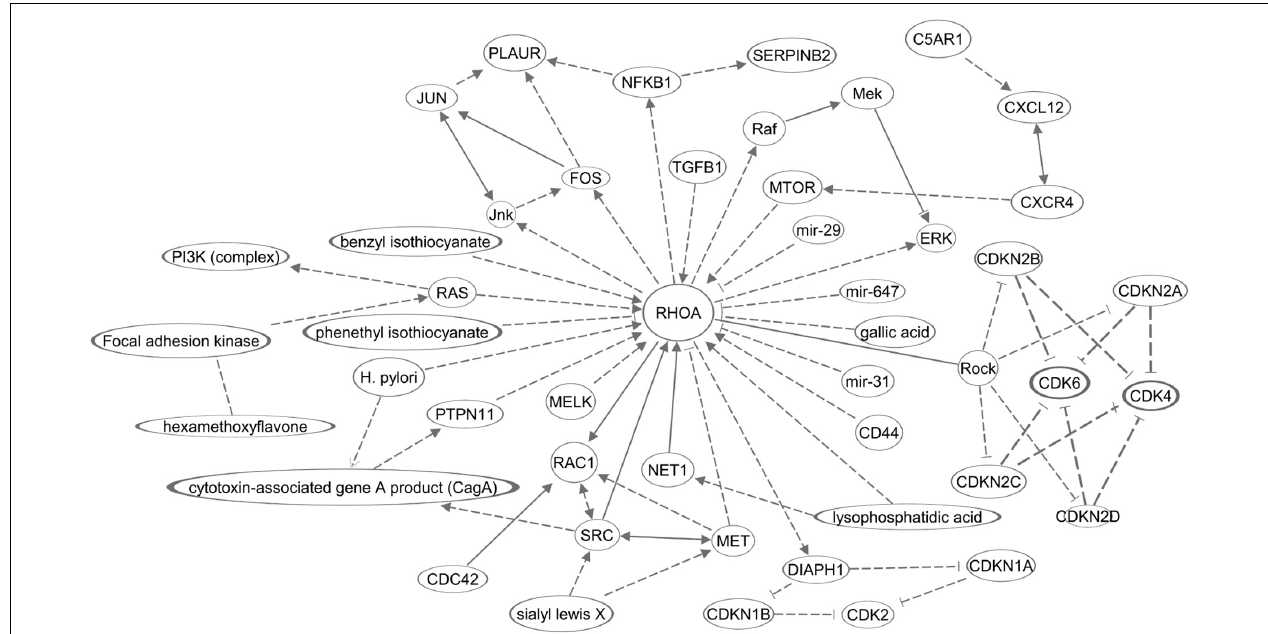
FIGURE 2 | A diagram of molecular networks of RHOA in GC. In GC, regulation of RHOA described in this review was represented in the networks. Solid lines represents established regulations, and dashed lines the regulations described in this review for